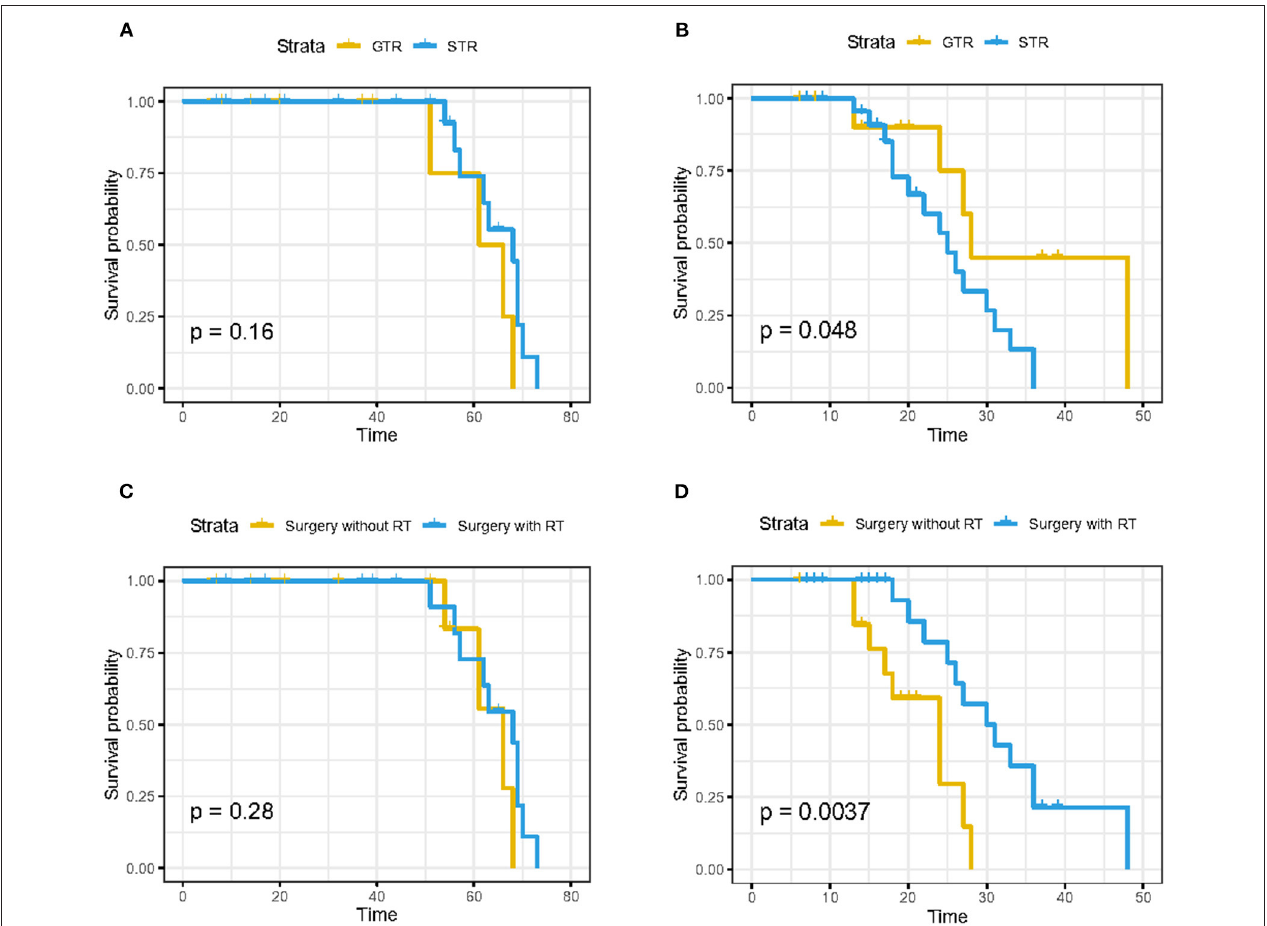
FIGURE 5 | Kaplan–Meier curves of OS in patients from Xiangya Hospital stratified by (A) gross total resection (GTR) and subtotal resection (STR), (C) surgery with radiotherapy and surgery without radiotherapy; K–M curves of progression-free survival in patients from Xiangya Hospital stratified by (B) GTR and STR and (D) surgery with radiotherapy and surgery without